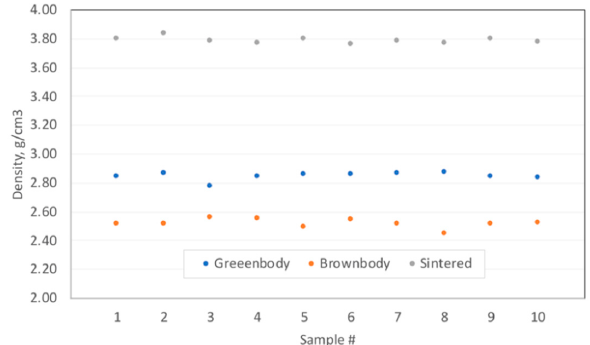
Figure 1. The density of the samples manufactured with stereolithography-based additive manufacturing workflow. The demonstrated samples (10 for greenbody, 10 for brownbody and 10 for sintered material) were evaluated independently. There are no inter-relations between the shown data-points.